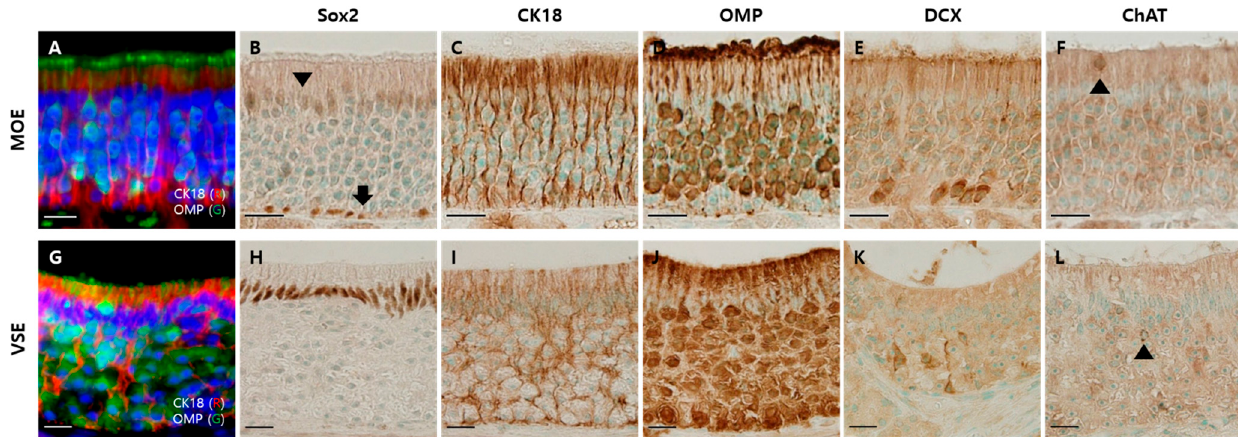
Figure 1. Olfactory system in the nasal cavity of the hamsters. Scale bars = 20 μ m. ( A ) Double immunofluorescent labeling of OMP and CK18 in the main olfactory epithelium (MOE), which are markers for mature olfactory sensory neurons (mOSNs) and supporting cells (SCs), respectively; ( B ) DAB staining with the antibody to Sox2 in MOE: nuclei of SCs (arrowhead) and basal cells (BCs, arrow); ( C ) DAB staining with the antibody to CK18 in MOE: cytoplasm and feet of SCs; ( D ) DAB staining with the antibody to OMP in MOE: mOSNs; ( E ) DAB staining with DCX antibody in MOE: immature olfactory sensory neurons; ( F ) DAB staining with the antibody to ChAT in MOE: microvillar cells (arrowhead); ( G ) double immunofluorescent labeling of OMP and CK18 in vomeronasal sensory epithelium (VSE); ( H ) DAB staining with the antibody to Sox2 in VSE: nuclei of SCs; ( I ) DAB staining with the antibody to CK18 in VSE: cytoplasm and feet of SCs; ( J ) DAB staining with OMP antibody in VSE: mature vomeronasal sensory neurons; ( K ) DAB staining with DCX antibody in VSE: immature vomeronasal sensory neurons; ( L ) DAB staining with ChAT antibody in VSE: solitary chemosensory cells (arrowhead).